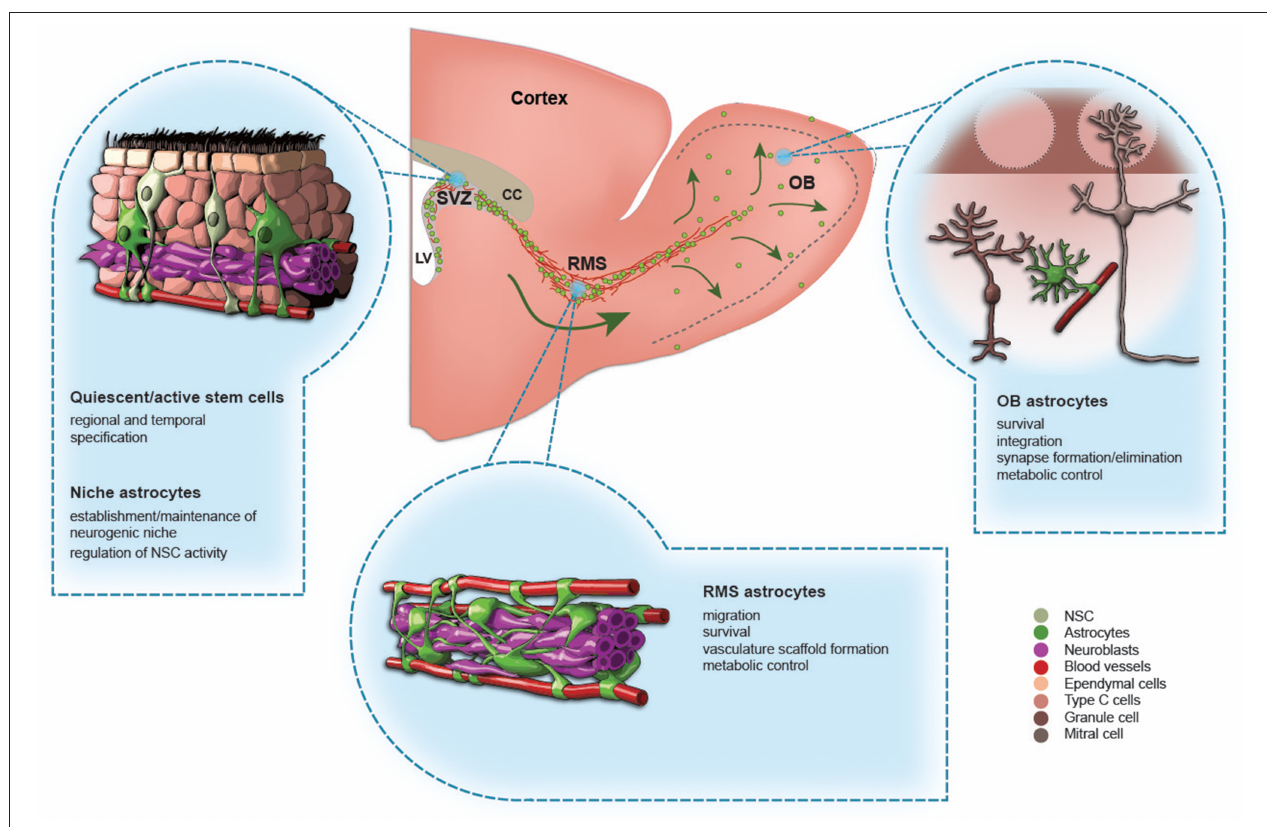
FIGURE 1 | The role of astrocytes in the adult olfactory bulb neurogenesis. A schematic drawing of the adult mouse forebrain and illustrations showing different types of astrocytes in the subventricular zone (SVZ), rostral migratory stream (RMS), and olfactory bulb (OB). The functions of each type of astrocytes are